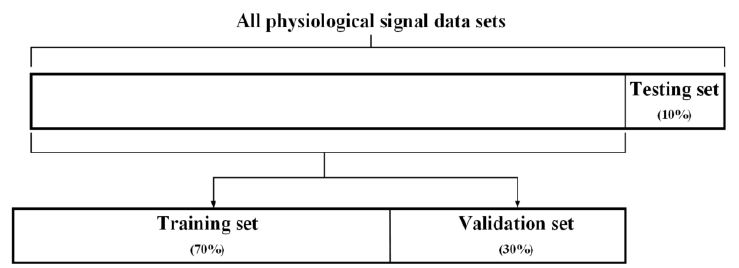
Figure 10. Data set of bowel sound signals assigned for training and